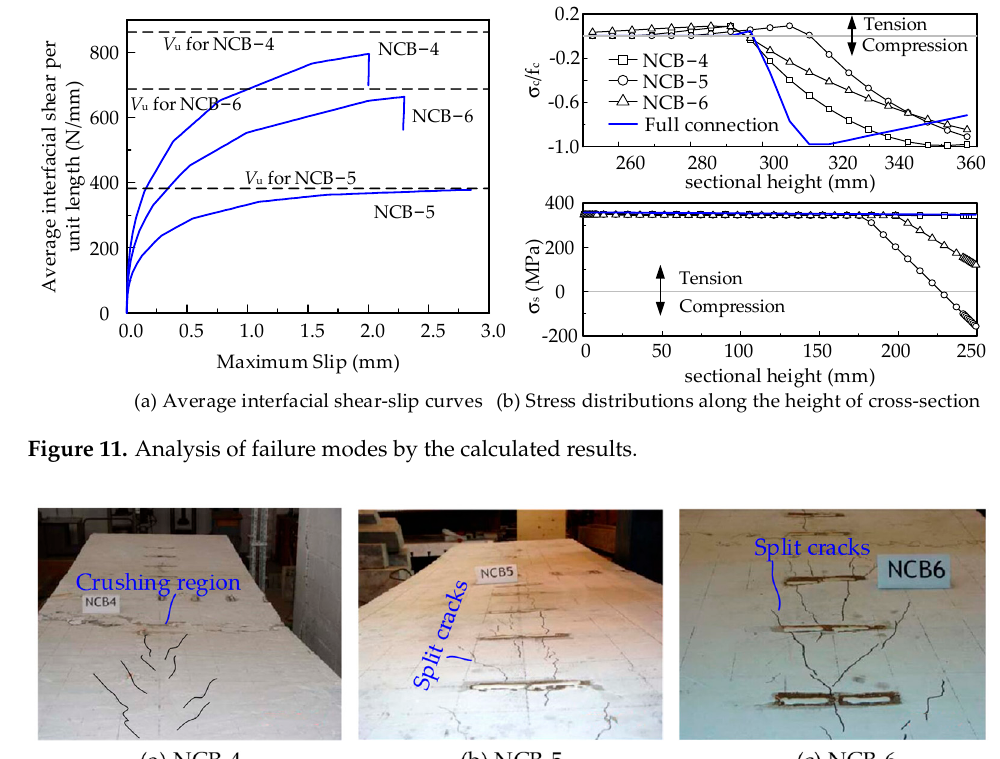
Figure 12. Failure modes observed in the tests.